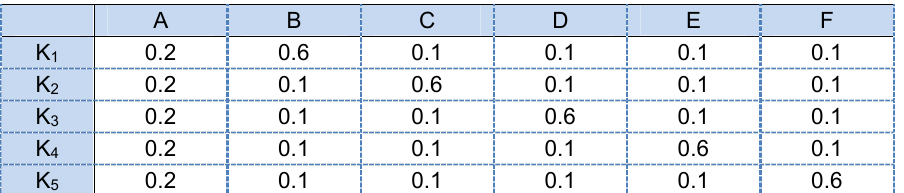
Table 15 – Scenarios with different weights of the criteria Таблица 15 – Сценарий изменения веса критерия